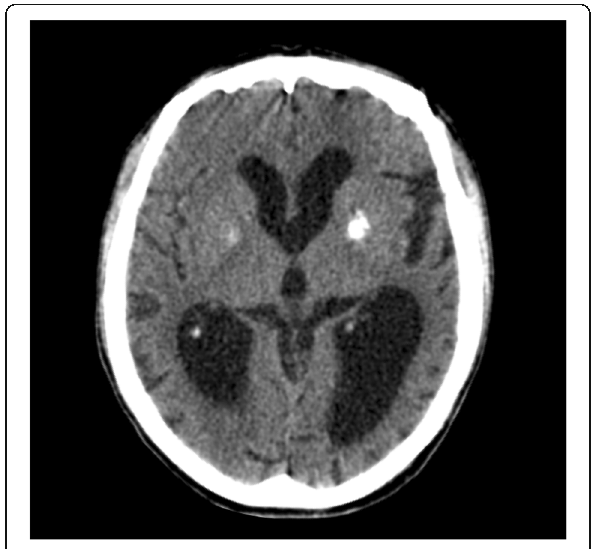
Fig. 12 Axial CT of a 46-year-old Down syndrome patient with basal ganglia calcifications, mainly involving the globus